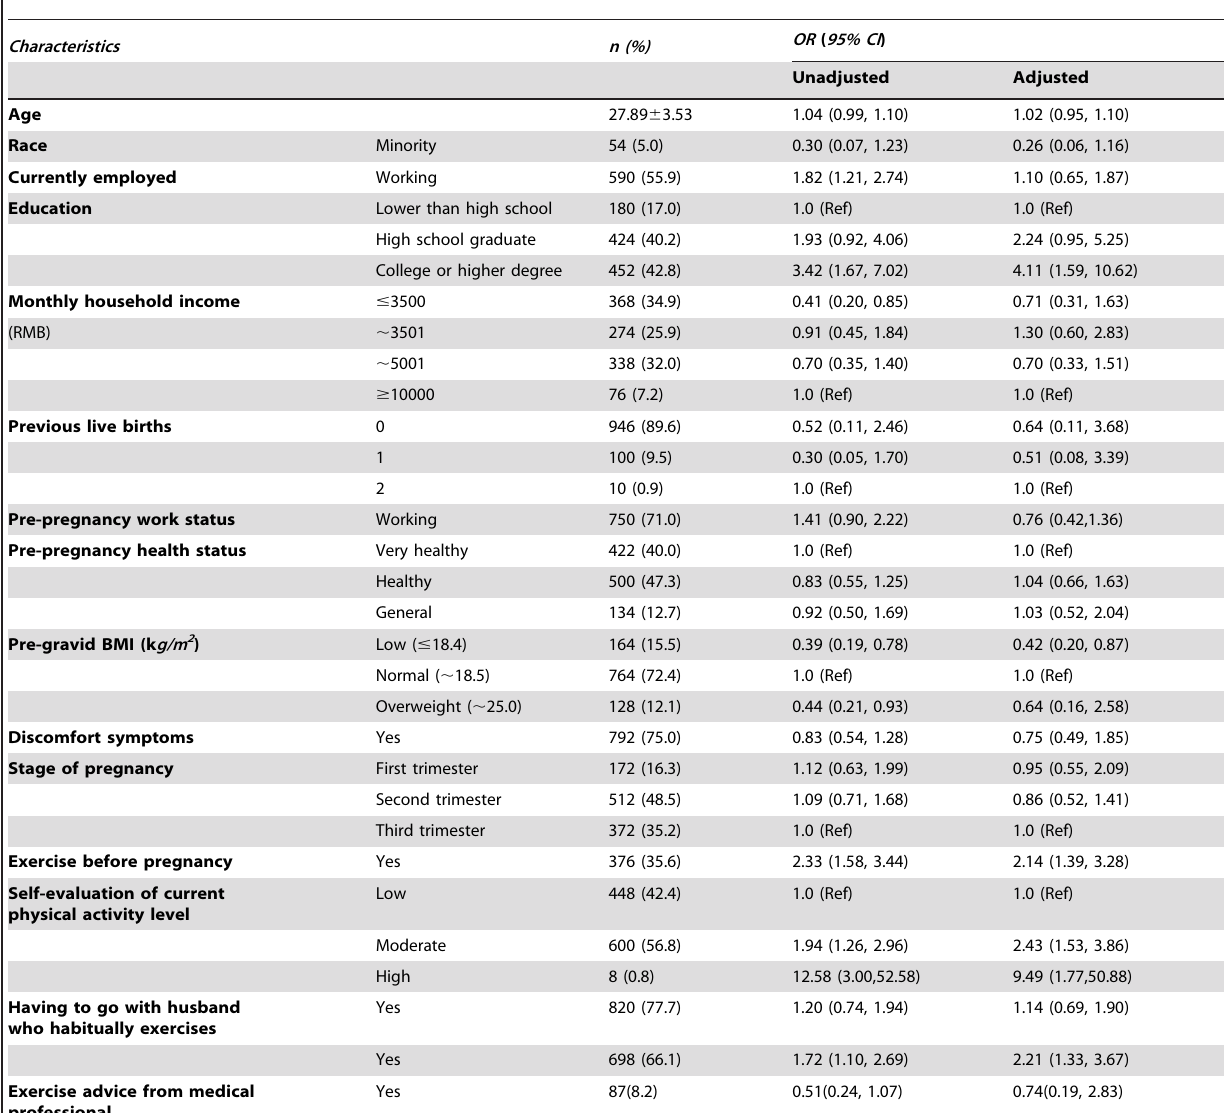
Table 5. Association between participants’ characteristics and the odds of meeting the guideline.